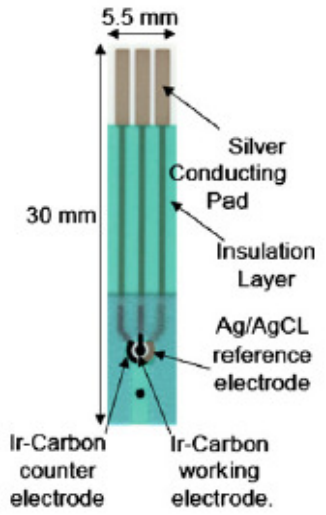
Figure 1. Schematic diagram of the disposable